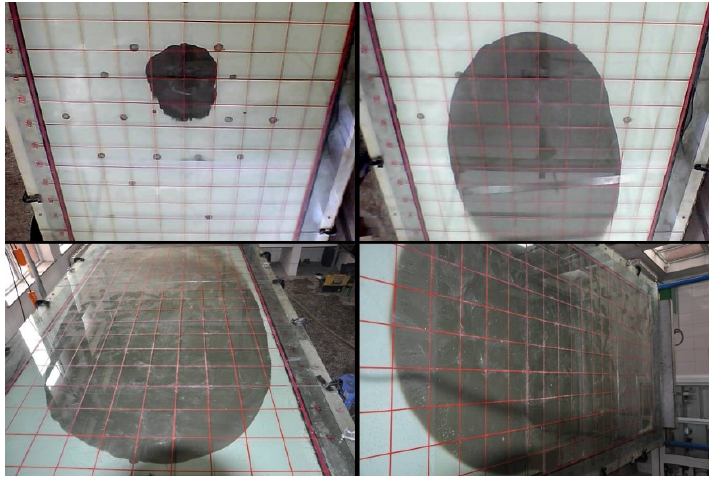
Figure 7. Grouting diffusion traces at a representative time (type 2). Water 2020 , 12 , x